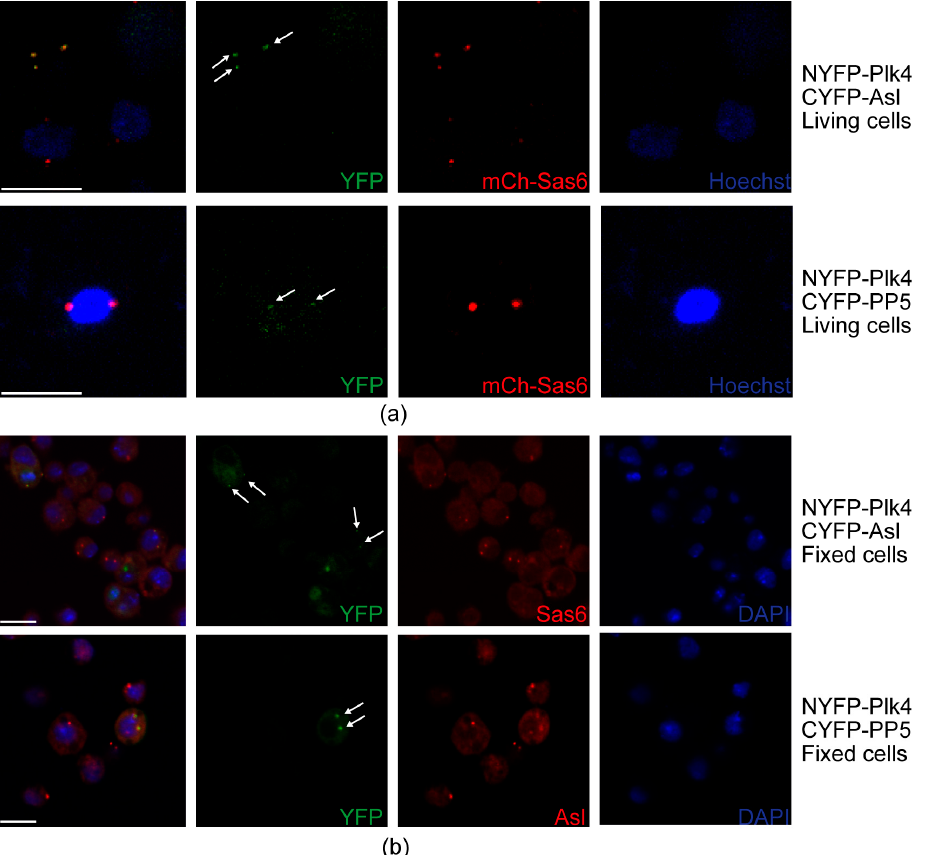
Figure 7. Interaction and co-localization of PP5 and Plk4 at the centrosomes. ( a ) Stills of live cell imaging of D.Mel-2 cells show that the co-expressed NYFP-Plk4 and CYFP-Asl (positive control), as well as NYFP-Plk4 and CYFP-PP5, co-localize (generate the green signal) to some of the mCherry-Sas6 (mCh-Sas6)-labelled centrosomes. Arrows indicate the co-localization. Co-expressed NYFP-Plk4 and CYFP, as well as CYFP-PP5 and NYFP, were used as negative controls (shown in Figure S7a). Hoechst 33342 was used to visualize DNA. Scale bar: 10 µ m ( b ) Representative microscopic images of fixed D.Mel-2 cells show that the co-expressed NYFP-Plk4 and CYFP-Asl (positive control), as well as NYFP-Plk4 and CYFP-PP5, interact and co-localize (generate the green signal) at the centrosomes (stained with anti-Sas6 or anti-Asl in far red, respectively). Co-localization was observed in 98% of the transfected cells ( n = 100 transfected cells). Arrows indicate the co-localization. Co-expressed NYFP-Plk4 and CYFP, as well as CYFP-PP5 and NYFP, were used as negative controls (shown in Figure S7b). DAPI was used to visualize DNA. Scale bar: 10 µ